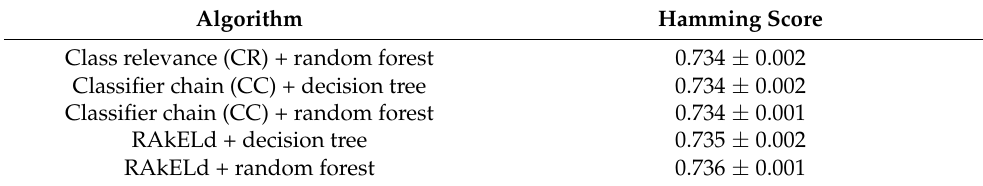
Table 3. Hamming score by different MTC algorithms.